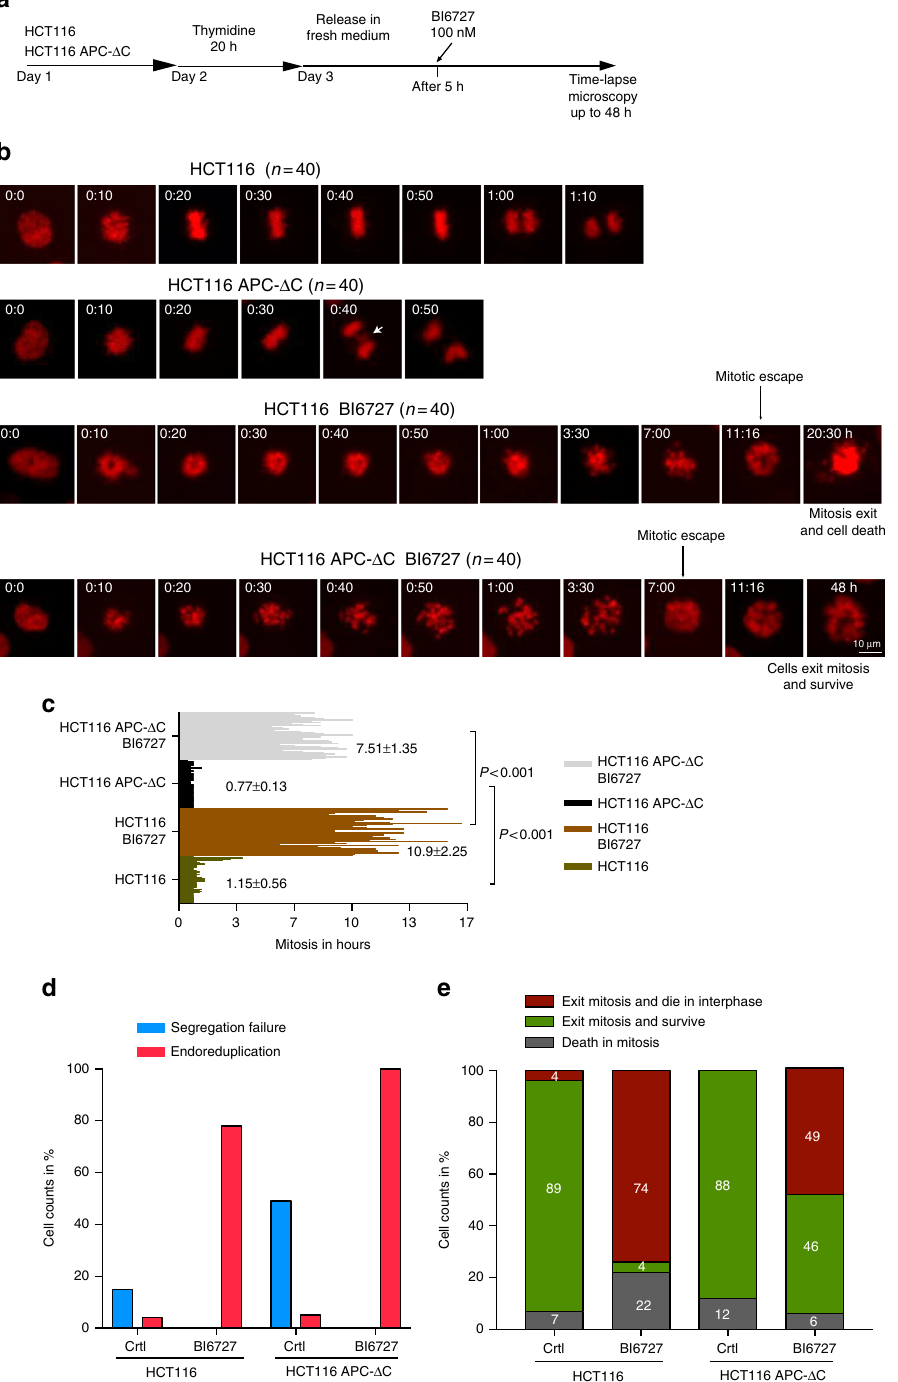
Fig. 2 PLK1 inhibition shortens mitosis, increased polyploidy and enhances cell survival in APC- Δ C-expressing HCT116 cells. a Treatment schedule for time- lapse microscopy. Cells were fi rst incubated with 2 mM thymidine to arrest them in the S-phase. After releasing the cells in fresh medium for 5 h, 100 nM BI6727 were added to cells and time-lapse microscopy was started up to 48 h after PLK1 inhibition. b Representative time-lapse of HCT116 and HCT116 expressing APC- Δ C mcherry-H2B treated as in ( a ) with or without 100 nM BI6727 (from t = 0 h to t = 48 h). The time of mitotic escape is indicated in the case of BI6727 treatment. The white arrow indicates lagging chromosomes observed during anaphase. Scale bar: 10 µ m. c Duration of mitosis in HCT116 and HCT116 expressing APC- Δ C treated with or without BI6727 was assessed by time-lapse microscopy. Mitotic duration of each cell in the different treatment groups ( n = 40) is quantitated in the bar graph. *** P < 0.001. d Segregation failure and endoreduplication rate observed in the different treatment groups in percentage. e Cell fate pro fi le of HCT116 and HCT116 expressing APC- Δ C treated with or without 100 nM